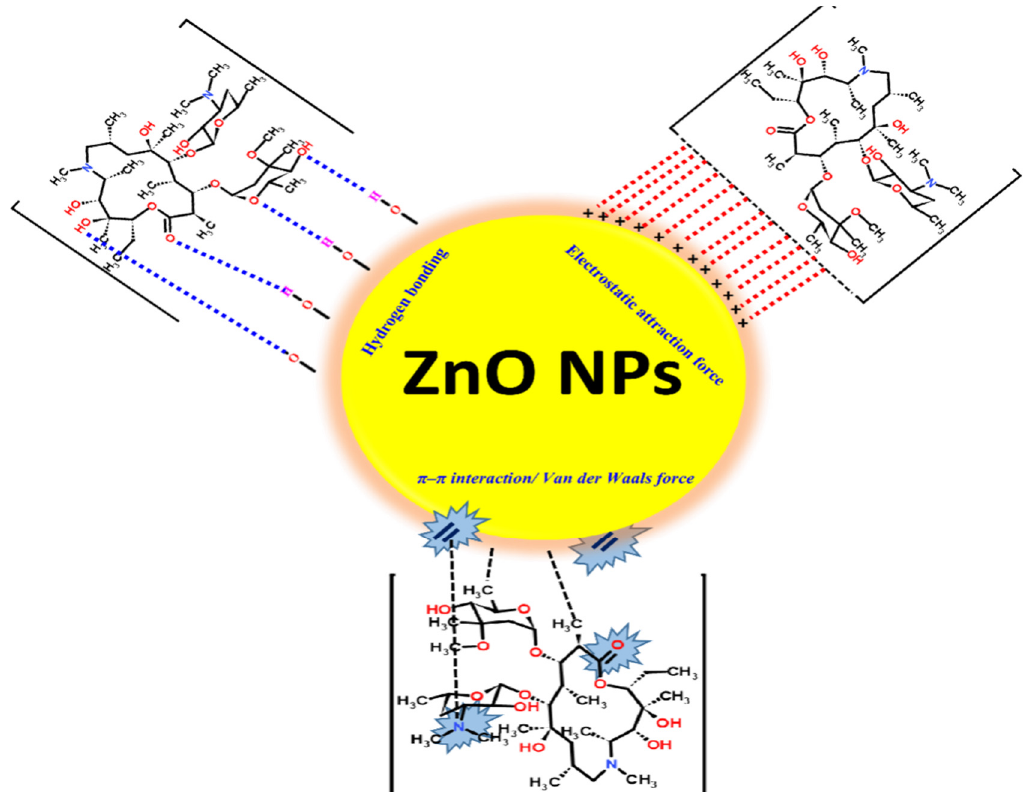
10 of 23 Figure 3. Removal performance of the AZM at different concentrations via ZnONPs. Adsorption Isotherm Studies The four different isotherm models were used to determine the most suitable model for design purposes. The isotherm calculations were done as shown in Table 3. Table 3. Isotherm models of the adsorption of AZM onto the ZnONPs.